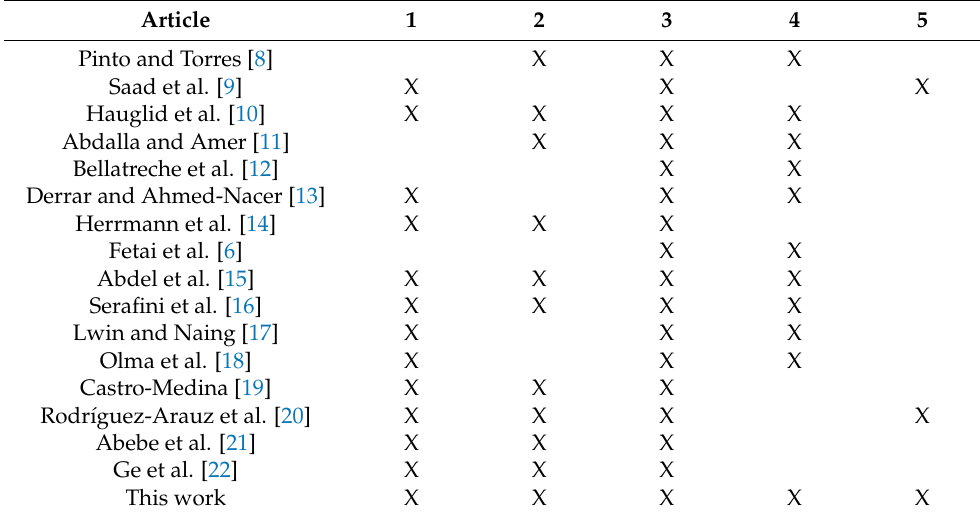
Table 1. Comparison of related works.